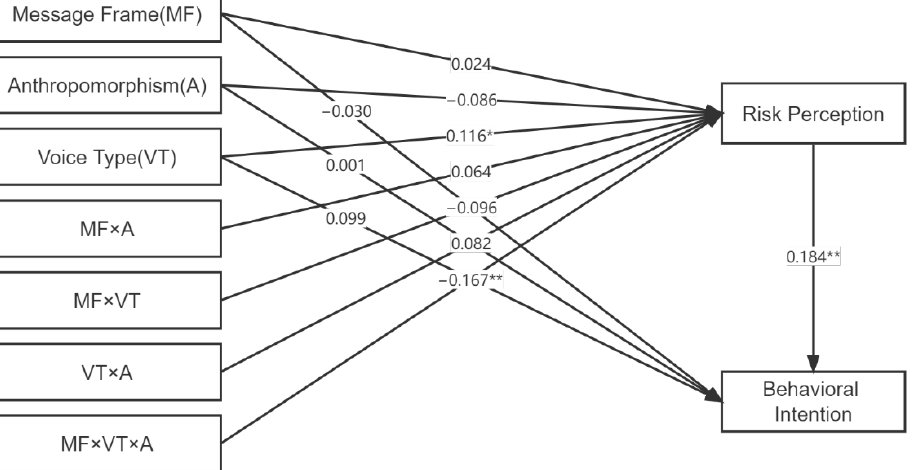
Figure 4. The research framework and path coefficients (the standardized regression coefficient).